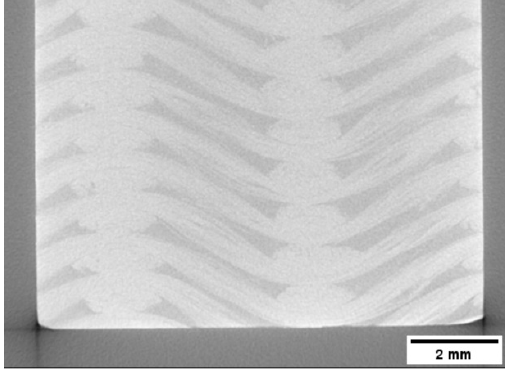
Figure 2. µ CT scan images of the 3D woven SiO 2f /SiO 2 composites in this study. Table 1. Measured geometric parameters of the 3D woven preform through µ CT. Table 1. Measured geometric parameters of the 3D woven preform through μ CT. Table 1. Measured geometric parameters of the 3D woven preform through μ CT. Number of Number of Number of Warp Yarn Weft Yarn Warp Yarn Weft Yarn Warp Yarn Weft Yarn Measurements Measurements Measurements